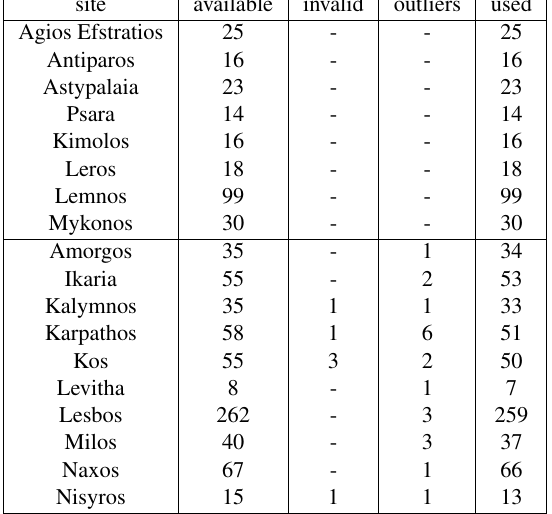
Table 3. Number of available control points, invalid points and outliers in each island.